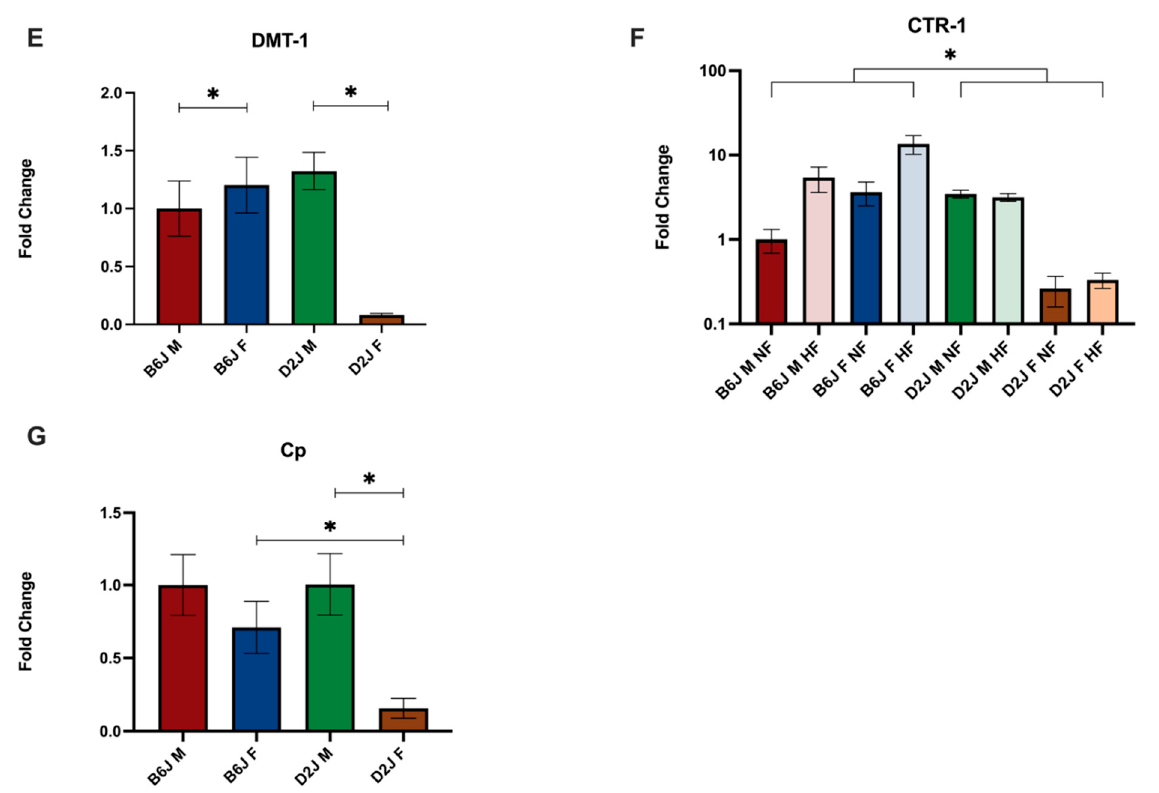
Figure 4. The effect of diet, sex, and strain on gene expression of proteins involved in trace element homeostasis in adipose tissue. Gene expression is expressed as fold change normalized to the B6J male normal-fat groups are shown for ( A ) hypoxia inducible factor- α , ( B ) hepcidin, ( C ) ferroportin, ( D ) iron regulatory protein-1, ( E ) divalent metal trasporter-1, ( F ) high affinity copper uptake protein-1, and ( G ) ceruloplasmin. Significant effect of high fat diet compared to normal fat group is denoted. Data are represented as mean ± SEM for B, D-G and median, 25th, 75th percentiles, minimum and maximum for A and C. * p < 0.05. B6J M NF = B6J male normal fat, B6J M HF = B6J male high